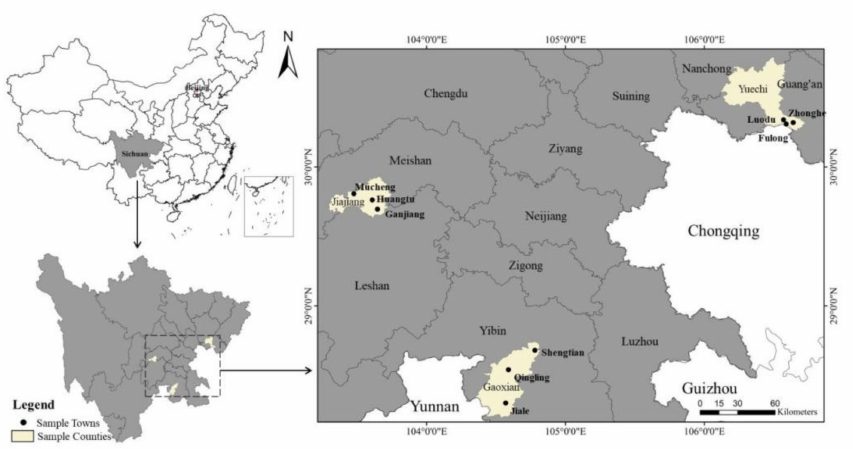
Figure 1. Distribution map of the sample